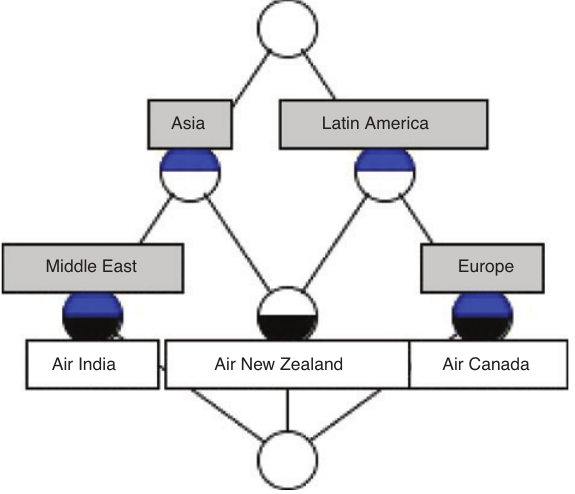
Figure 2: Concept Lattice Generated for Formal Context Given in Figure